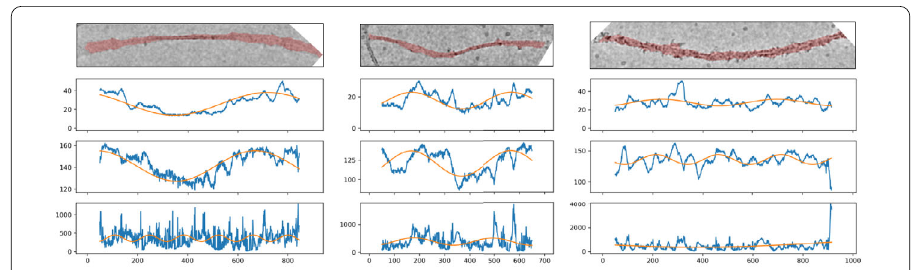
Figure 4 Three examples of segmented fibrils, showing the (rotated) grayscale image of the fibril (top row), the width of the fibril along its major axis (second row), as well as the mean gray value (third row) and the variance in gray values (bottom row) at each slice orthogonal to the major axis. Each curve is overlaid with an fitted sine function shown in